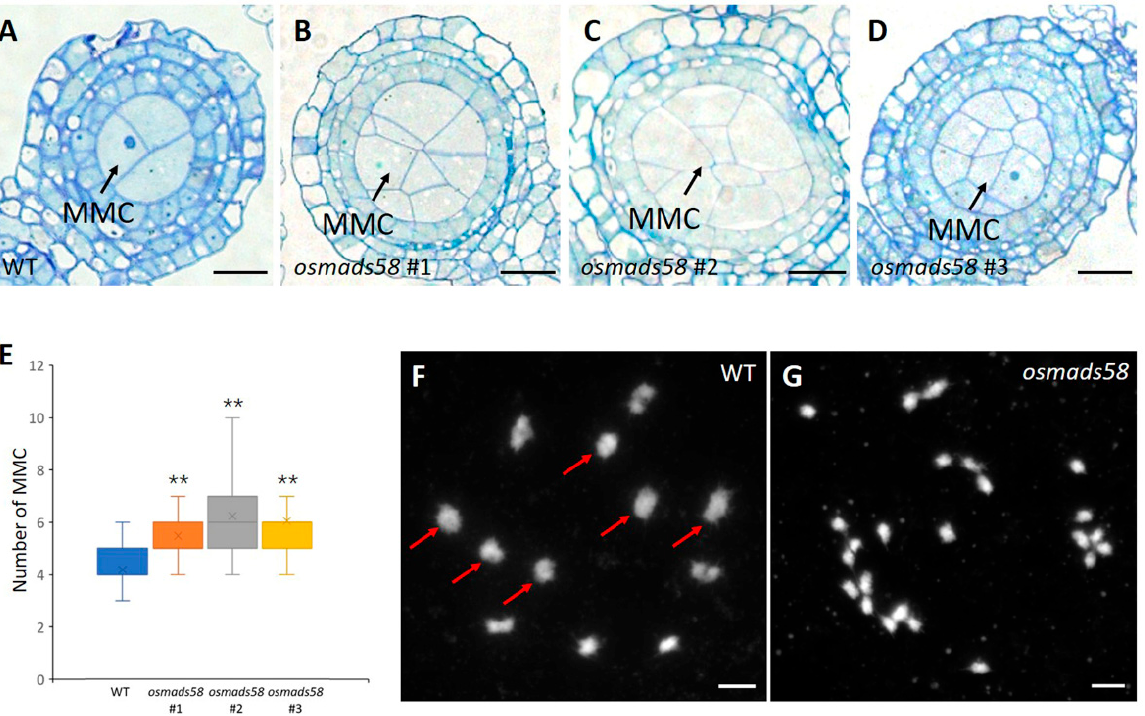
Figure 3. The number of microspore mother cells increases and the meiocytes exhibit severe defects in crossover formation in osmads58 CRISPR lines. ( A – D ) Semi-thin transverse sections of one lobe of anthers in the wild type ( A ) and osmads58 CRISPR ( B – D ) at stage 5. There were more microspore mother cells in all three lines of osmads58 CRISPR compared to the wild type. Bars, 20 µ m. MMC, microspore mother cell. ( E ) The number of microspore mother cells (MMC) in the wild type and three osmads58 CRISPR lines. Error bars represent sd ( n = 37). Student’s paired t -test: ** p < 0.01. ( F , G ) Comparison of chromosome behaviors in wild-type ( F ) and osmads58 CRISPR ( G ) meiocytes at diakinesis, many univalents formed. The red arrows show normally paired chromosomes. Chromosomes were stained with 4 ′ ,6 ‐ diamidino ‐ 2 ‐ phenylindole (DAPI). Bars, 5 μ m.